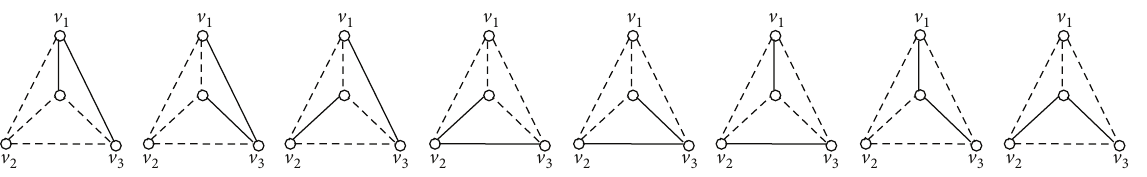
Figure 4: The number of spanning forests with two components of 𝑀(1) is 8. The solid link indicates that one node is connected to another node; the dashed link indicates that one node is not connected to another